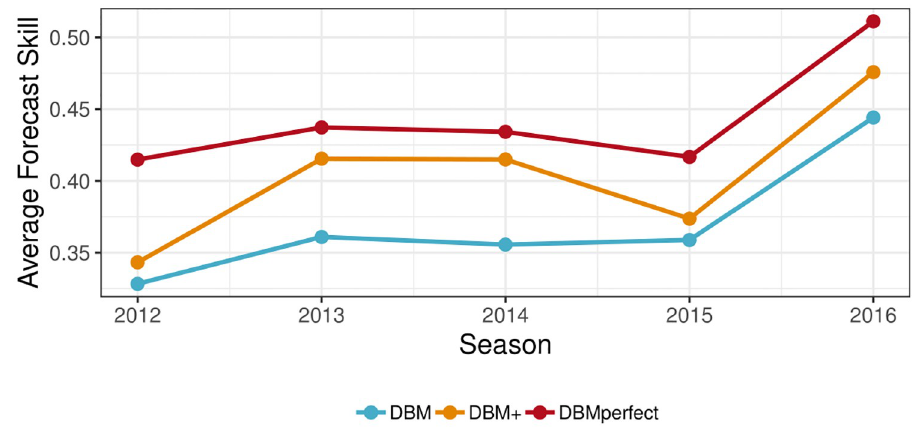
Fig 10. Average forecast skill by season, averaged over all regions and targets ( s average forecast skill for all seasons, followed by DBM+ and DBM, respectively.